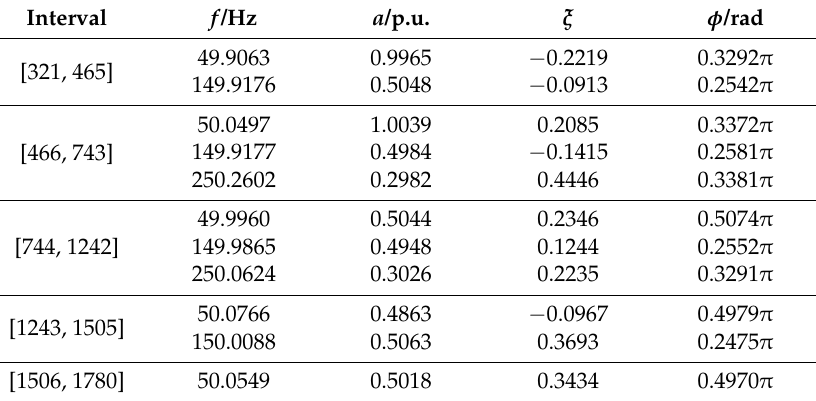
Table 4. Comparative analysis of the proposed method, Prony method (order = 6), and the TLS- ESPRIT (order = 6)/%.